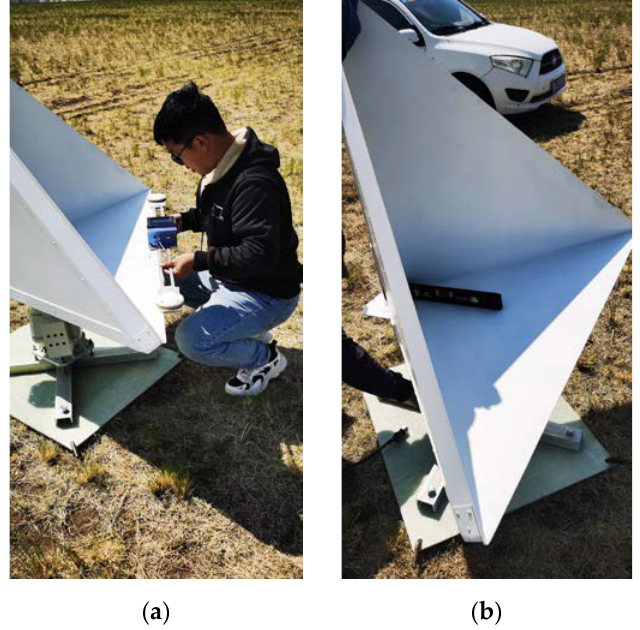
Figure 6. Automatic corner reflector review of azimuth and elevation angle. ( a ) Reviewing the azimuth angle with north marker, ( b ) Reviewing the elevation angle with level meter.